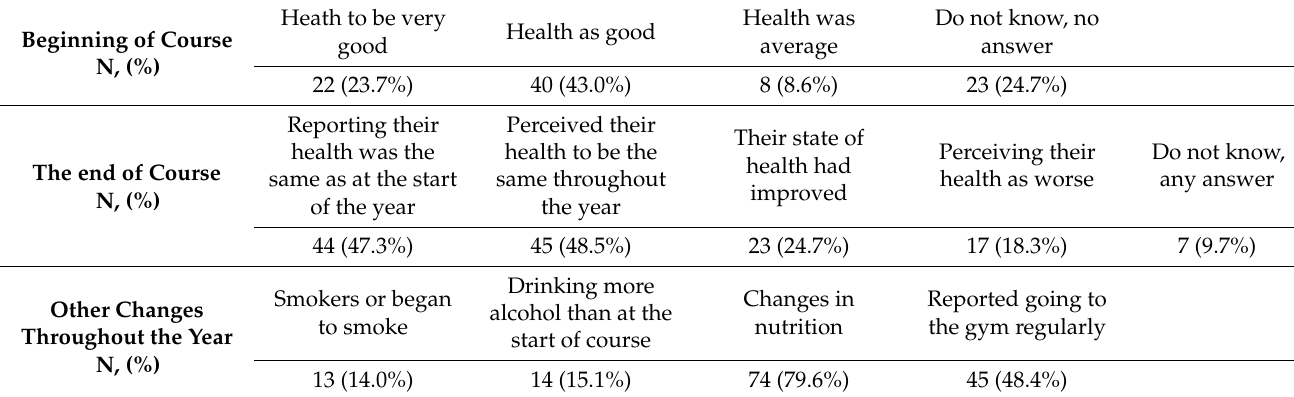
Table 5. Indicator of perception of their state of health at the beginning and end of